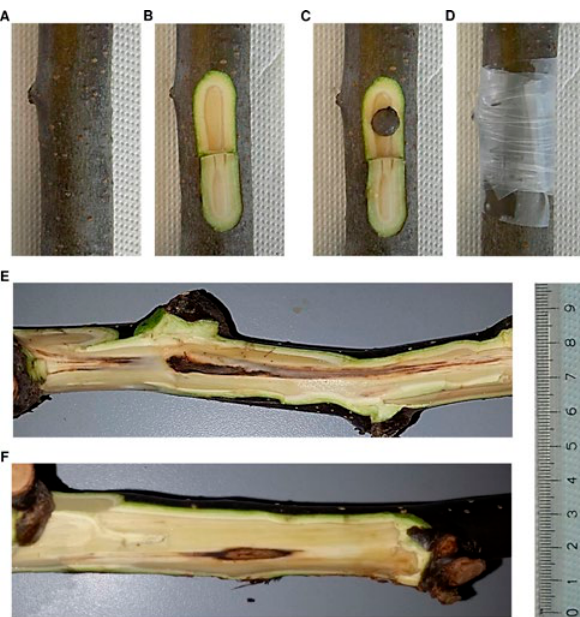
Figure 3. Inoculation procedure of a) 3-y-old apple trunk and b) cut to obtain a longitudinal wound. Each wound was c) inoculated with a mycelium plug or sprayed with conidium suspension (exam- ple as in the panel b), and d) covered with laboratory plastic film. Disease severity was assessed on e) mycelium plug-inoculated and f) conidium suspension-inoculated trunks 60 d after incubation under greenhouse conditions. Length (cm) is specified by the ruler on the right.